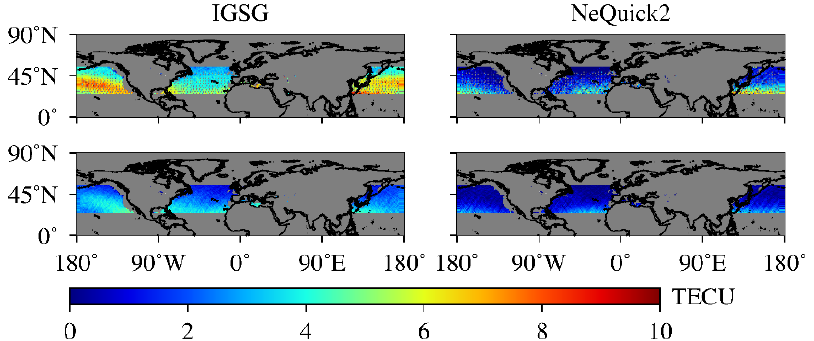
Figure 9. The distribution of the mean deviations of the IGSG and NeQuick2 model with respect to the reference of Jason2 VTEC. Figures from top to bottom denote high solar condition year and low solar condition year, respectively.